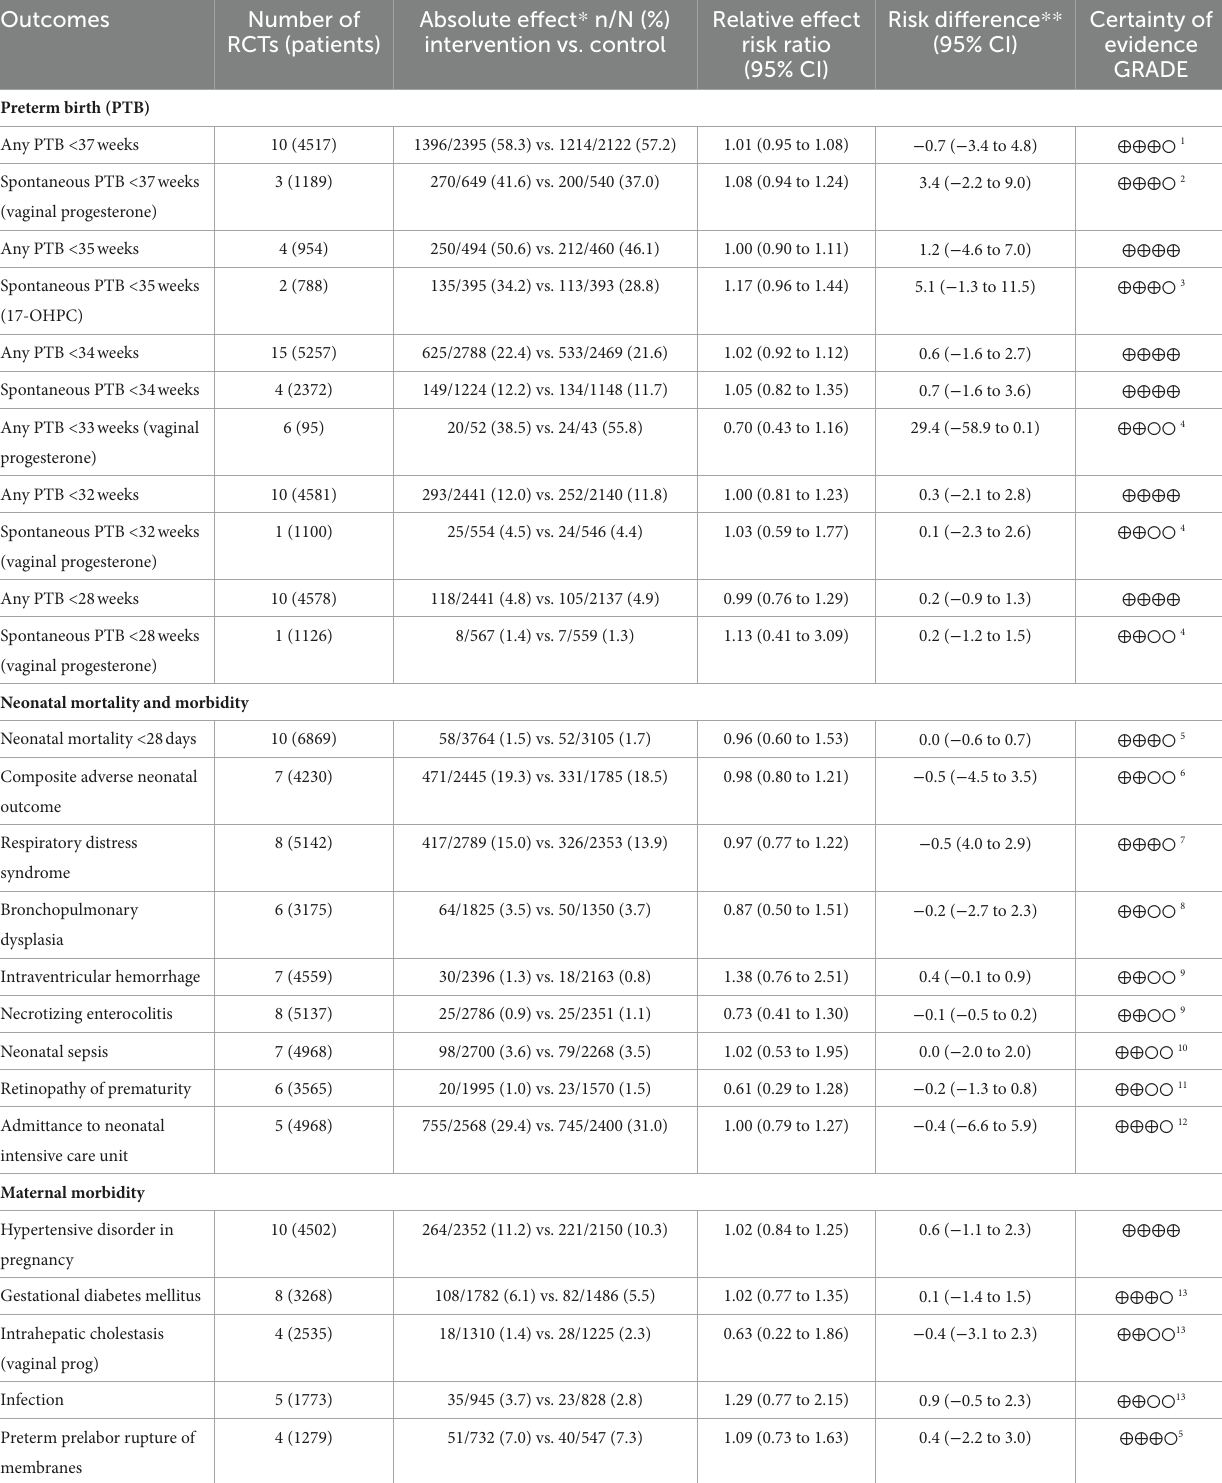
* Absolute effects for event rates in intervention group vs. control group, presented as the sum of all events /the total numbers of participants, across the RCTs with low risk of bias. ** Pooled risk difference (95% CI), presented as the weighted difference in event rates per 100 participants. Reasons for downgrading: 1 One level based on some inconsistency (I 2 38%) and some indirectness (high proportion IVF pregnancies). 2 One level based on serious indirectness (34–95% IVF pregnancies). 3 One level based on uncertain directness (unclear selection process) and uncertain precision. 4 Two levels based on very serious imprecision. 5 One level based on serious imprecision. 6 Two levels based on some variation in the definition of the composite outcome, and serious inconsistency (I 2 61%). 7 One level based on various definitions of the outcome and serious inconsistency (I 2 64%). 8 Two levels based on some study limitations and inconsistency (I 2 48%) and serious imprecision. 9 Two levels based on some study limitations and serious imprecision. 10 Two levels based on various definitions of the outcome, serious inconsistency (I 2 75%) and uncertain precision. 11 Two levels based on some study limitations, inconsistency (I 2 29%), and serious imprecision. 12 One level based on serious inconsistency (I 2 84%). 13 One level based on some imprecision and no definition of GDM in most trials. 14 Two levels based on various definitions of the outcome and serious